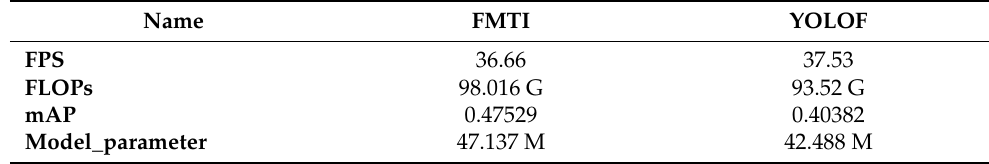
Table 5. FMTI and YOLOF comparison